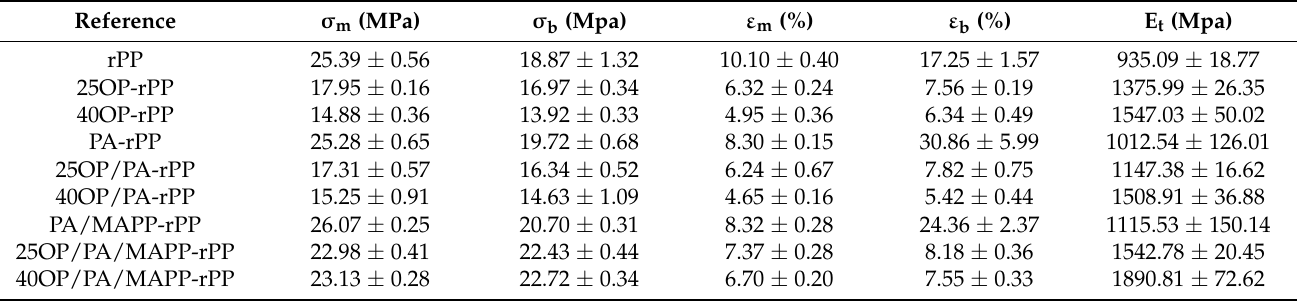
Table 4. Tensile properties of biocomposites and